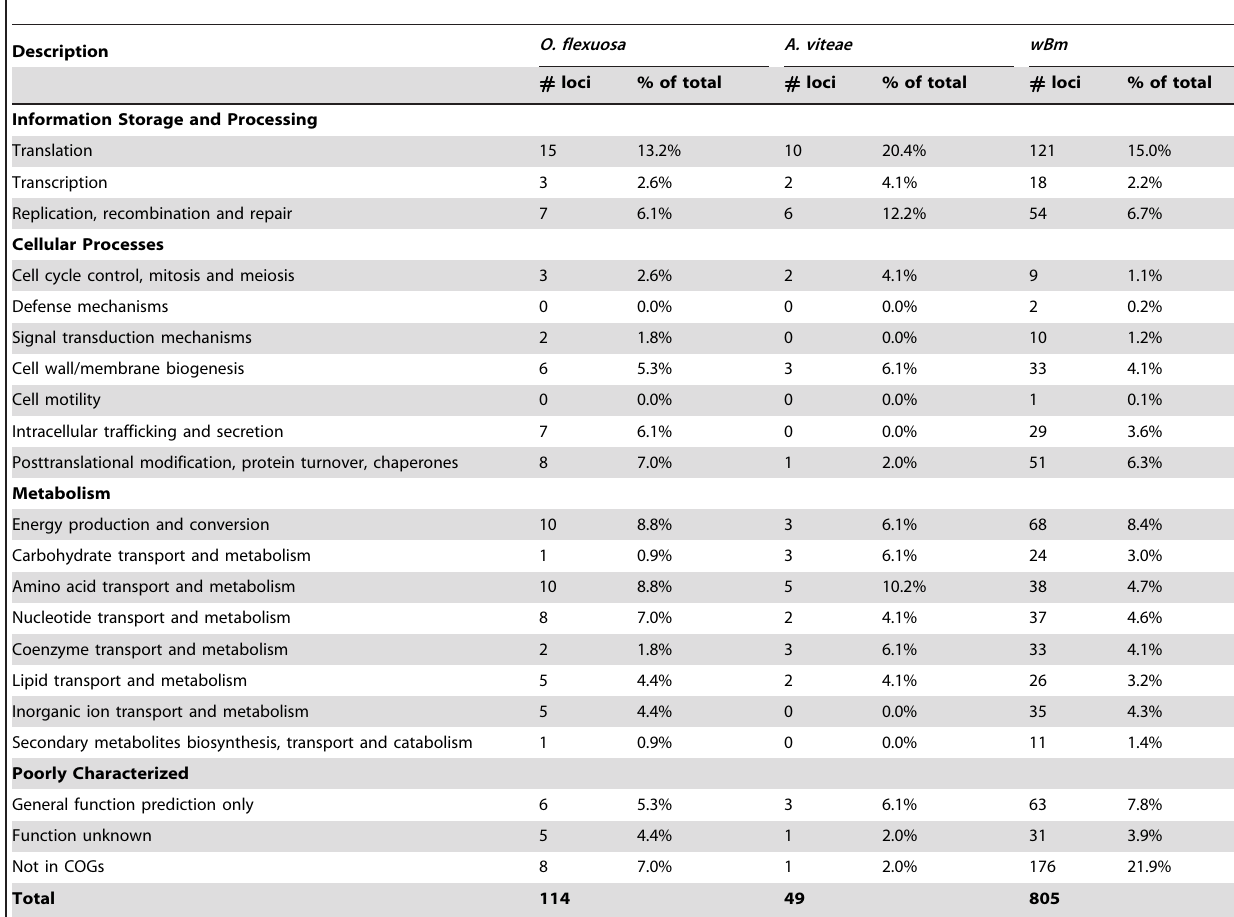
Table 3. Assignment of Wolbachia -like sequences to COG functional